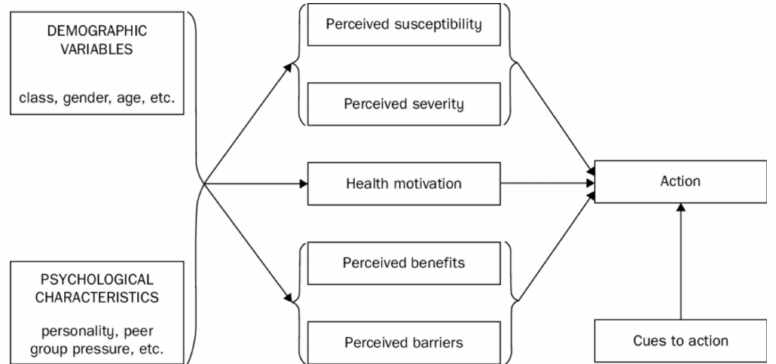
Figure 3. The health belief model. Reproduced from Rosenstock, I.M., Historical origins of the health belief model; published by Health Education Monographs, 1974.